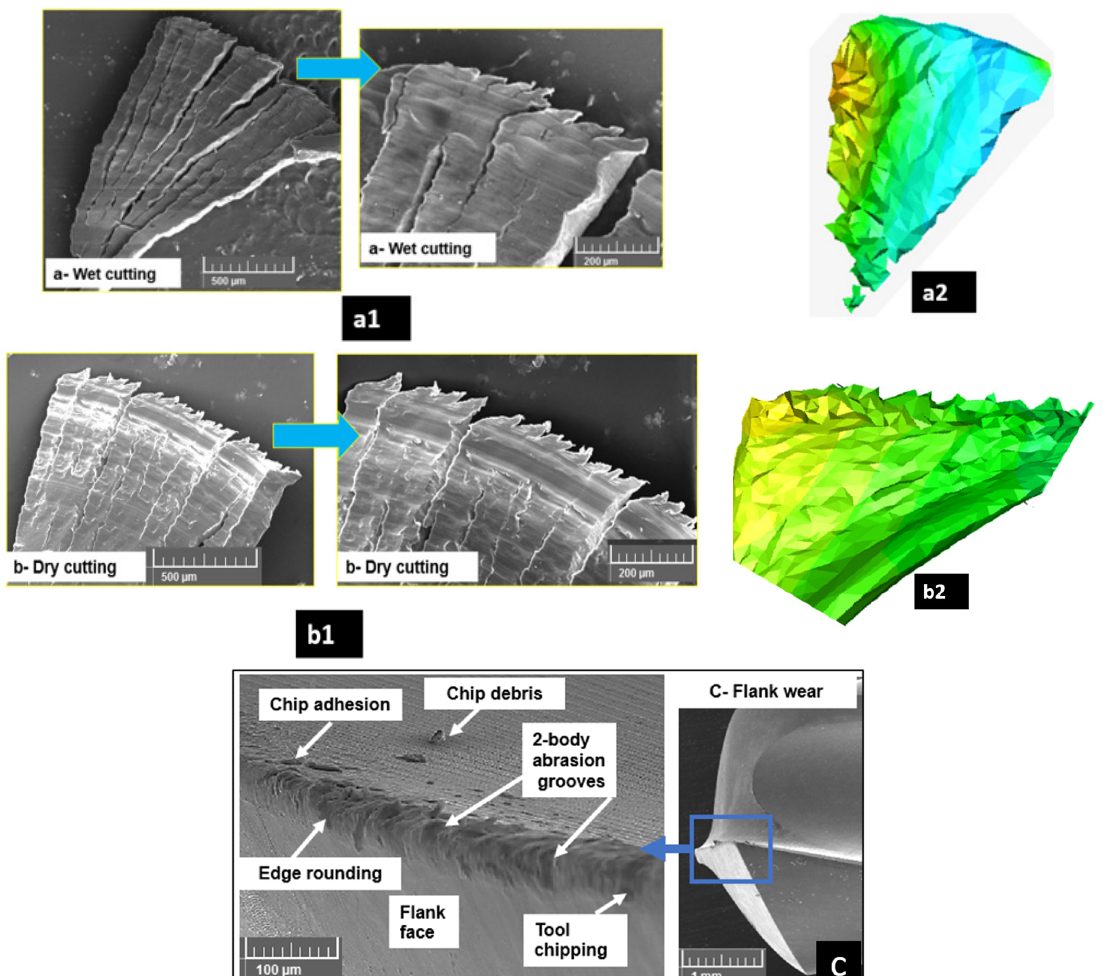
Figure 15. Chip morphology of Mg-9Al-1.4Zn hollow alumina foam: ( a1,a2 ) experimental and FE predicted wet cutting chips; ( b1,b2 ) experimental, and FE predicted dry cutting chips; ( c ) representative tool wear.